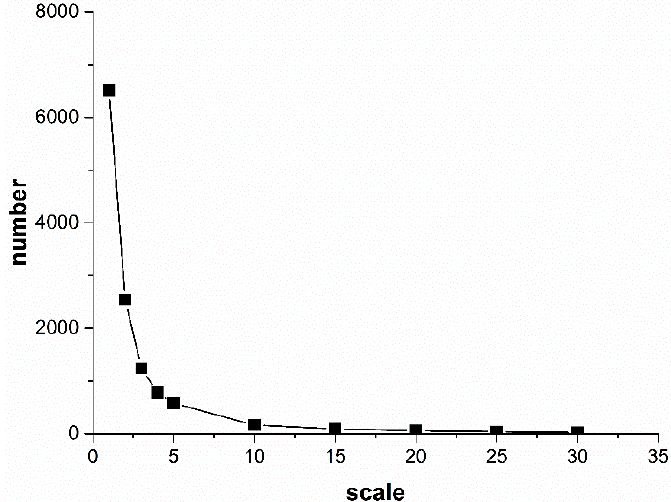
Figure 5. of segments changes with segmentation scale factor using multi-resolution segmentation in eCognition.